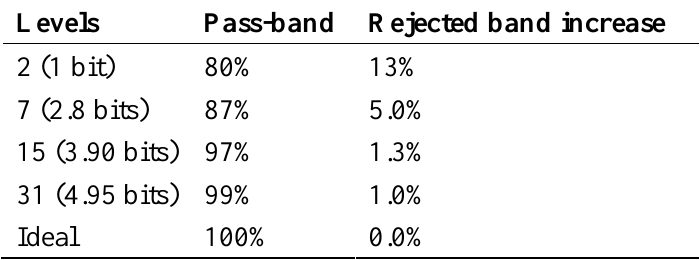
Table 2. Summary of the spectrum distortion and spread for V quantization schemes.